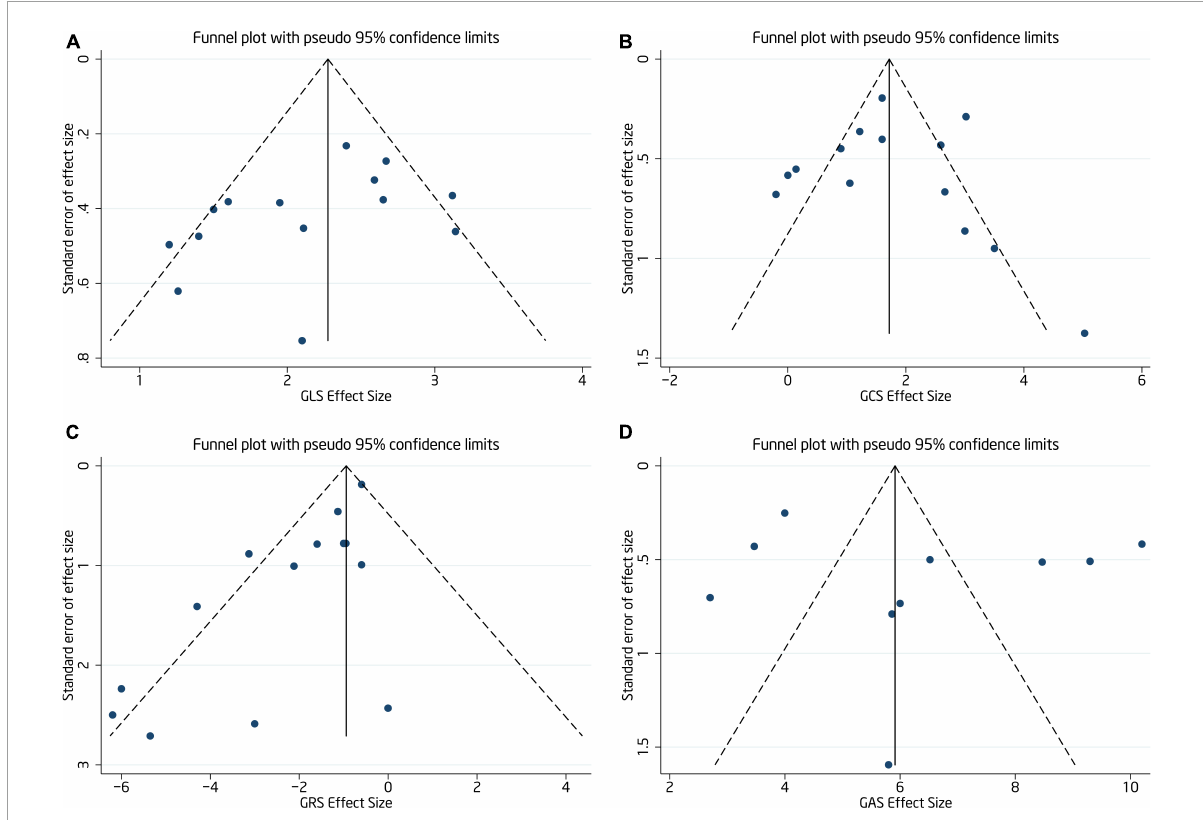
FIGURE4 Funnel plot of GLS (A) , GCS (B) , GRS (C) , and GAS (D) (The symmetry of funnel plot was used to evaluate the publication bias of included